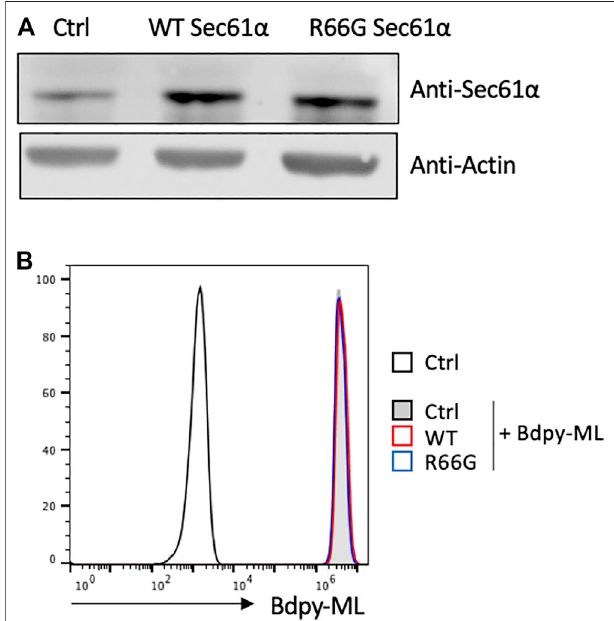
FIGURE 5 | Intracellular incorporation of Bdpy-ML in lymphocytes is independent of the level of Sec61 α . (A) Detection, as done by western blot, of Sec61 α (Top lane) or Actin (bottom lane) in primary mouse T cells either non- transfected (Ctrl) or transfected with the wild type form of Sec61 α (WT), or with the mycolactone-resistant Sec61 carrying the R66G mutation (R66G) (B) Histogram showing incorporation of Bdpy-ML as measured by FACS in non-transfectedmouseTcells(Ctrl) orinWT-orR66G-transfected cells.Cells were loaded with different doses of cell trace to identify each population, mixed in equivalent proportion and incubated 24 h with Bdpy-ML. Incorporation of Bdpy-ML was measured by FACS in each cell population identi fi ed by cell trace